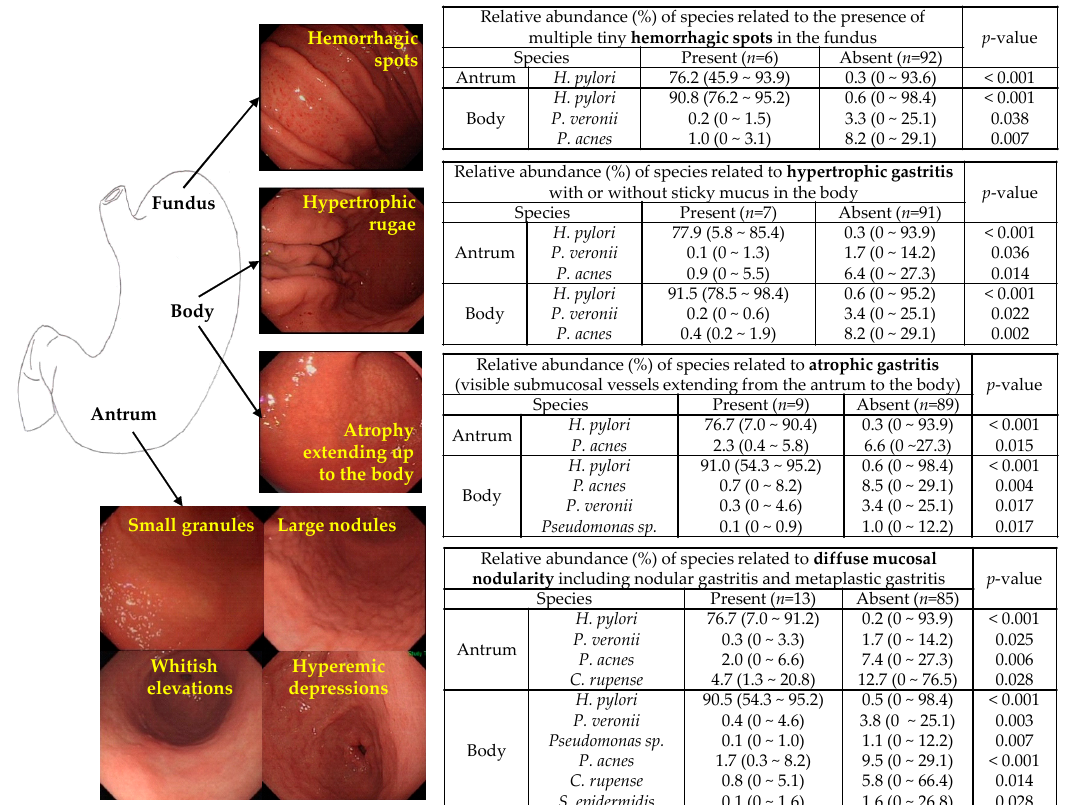
Figure 3. Significant endoscopic findings that were correlated with the relative abundance of microbiota. Helicobacter pylori was abundant in the presence of hemorrhagic spots, hypertrophic rugae, advanced atrophy, and mucosal nodularity, whereas Pseudomonas veronii and Propionibacterium acnes were abundant in the absence of these findings. Pseudomonas sp. was abundant in the absence of atrophy and nodularity. Moreover, Cloacibacterium rupense and Staphylococcus epidermidis were abundant in the absence of nodularity. The median relative abundance of each species were provided with range (minimum–maximum) using the Kruskal–Wallis test. H. pylori: Helicobacter pylori; P. veronii: Pseudomonas veronii; P. acnes: Propionibacterium acn é s; C. rupense: Cloacibacterium rupense; S.